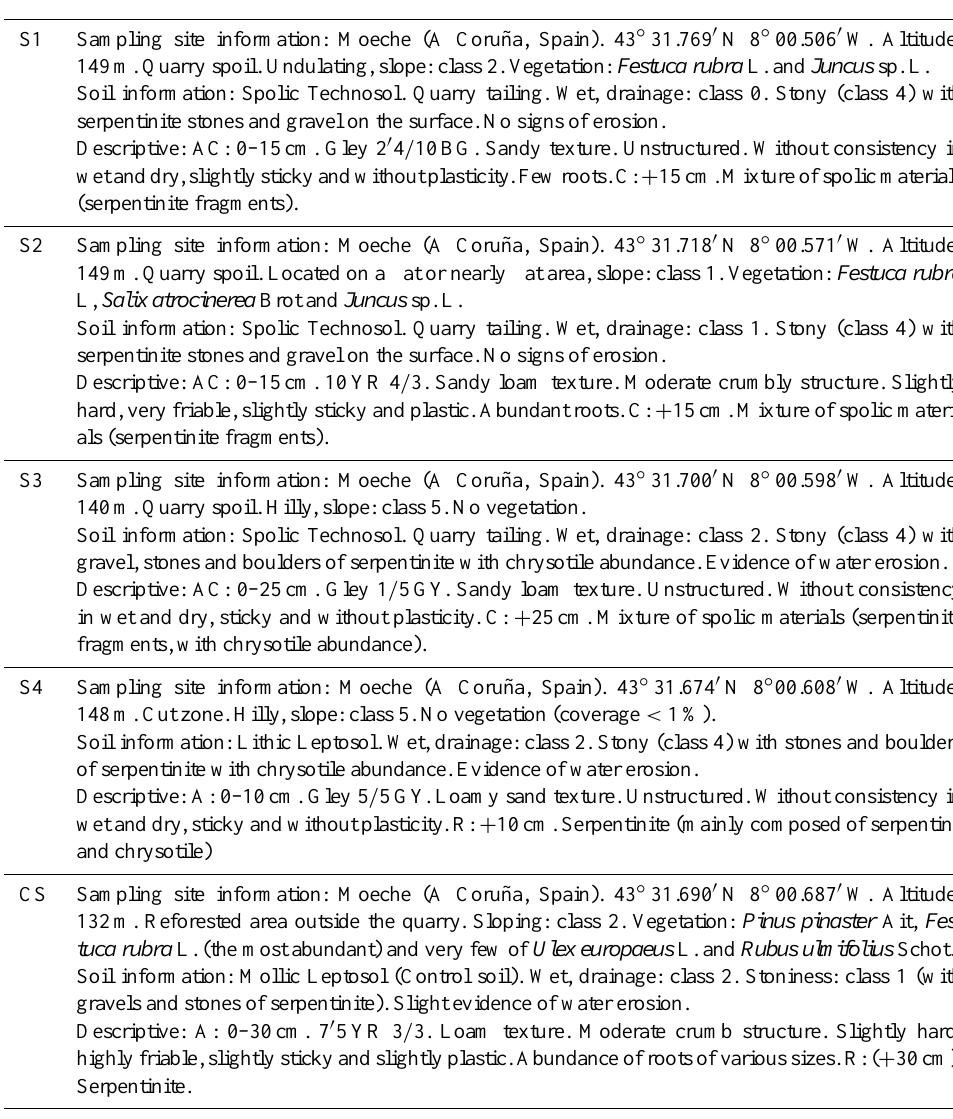
Table 1. Profile